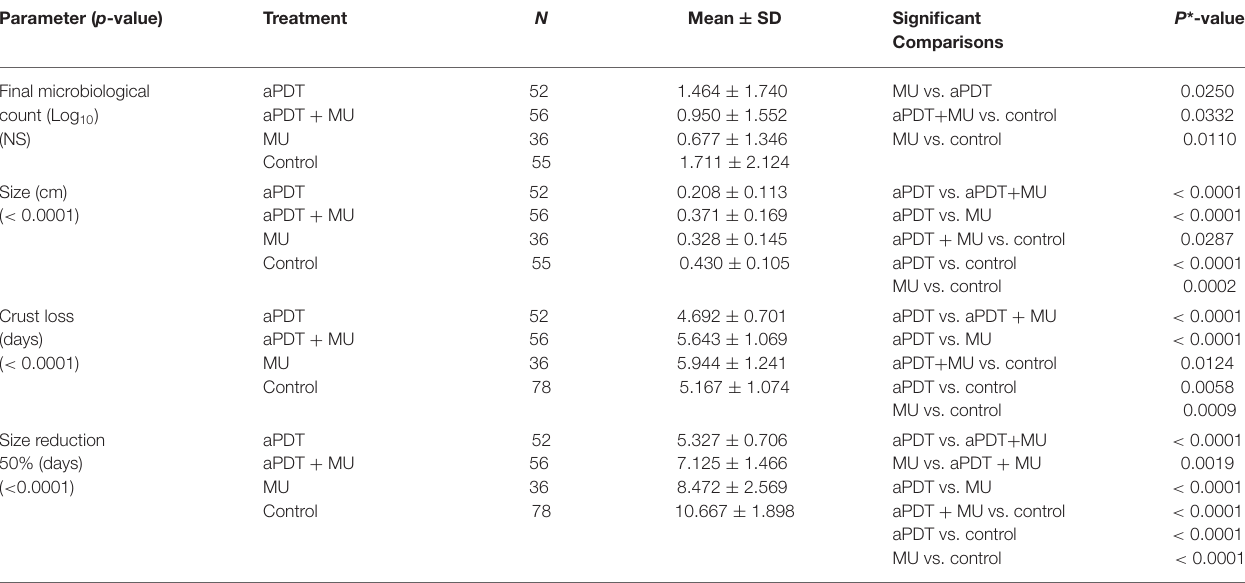
TABLE 4 | Multiple comparison of quantitative effects of the different treatment vs. untreated